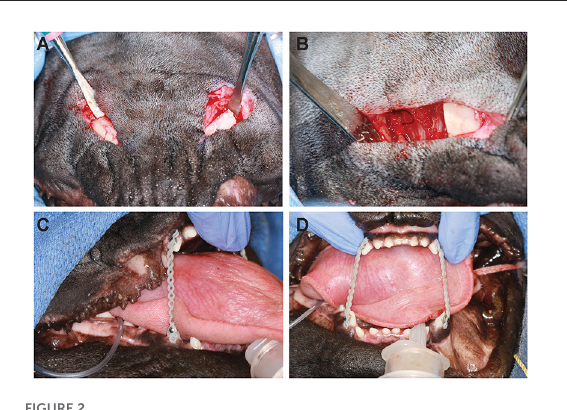
FIGURE2 Intraoperative images of the extraoral approach to bilateral segmental mandibulectomy and placement of the elastic orthodontic training device in case 1. (A) Two skin incisions are made on the ventral aspects of the mandibles. (B) Osteotomies are created using a piezoelectric surgical unit, and the segment of bone is removed through the extraoral incision. (C,D) Orthodontic buttons are placed on maxillary and mandibular canine teeth, and elastic power chains are placed between them to help minimize ventral deviation during soft tissue